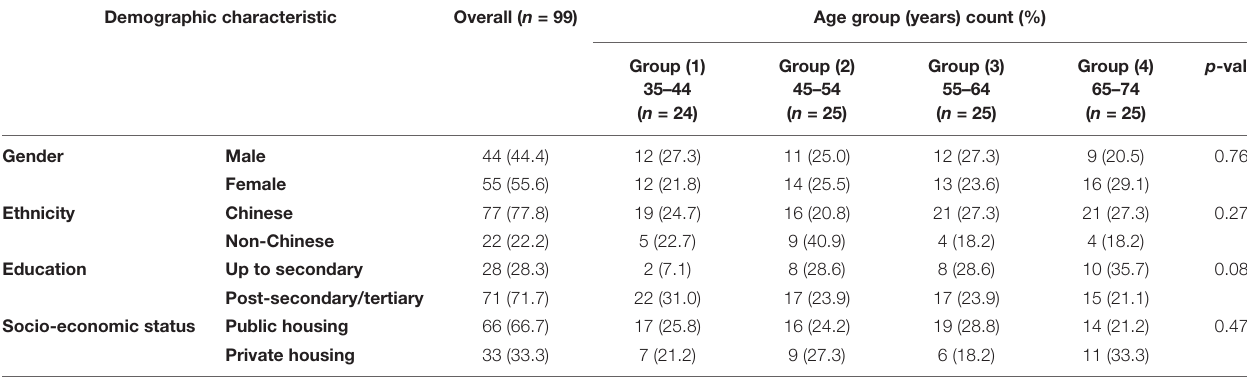
FIGURE 1 | Cognitive domains assessed in the Cognitive Assessment by VIrtual REality (CAVIRE) segments. TABLE 1 | Demographic characteristic frequency counts (%) and comparison among age